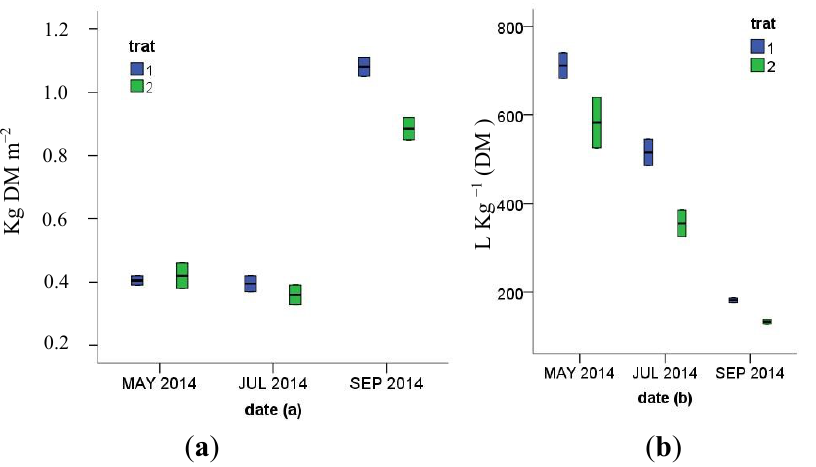
Figure 3. ( a ) Yield (kg·DM·m −2 ) and ( b ) water consumption per dry matter produced, water consumption coefficient (L·kg −1 DM) for both treatments (trat 1: 100% and trat 2: 60% of the dose) and∙harvests.